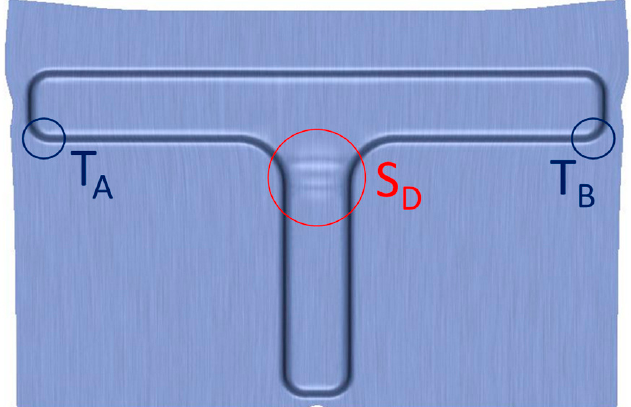
Figure 5. Areas of the component with formability and cosmetic defects (thinning in T A and T B and surface deflections in S D ).